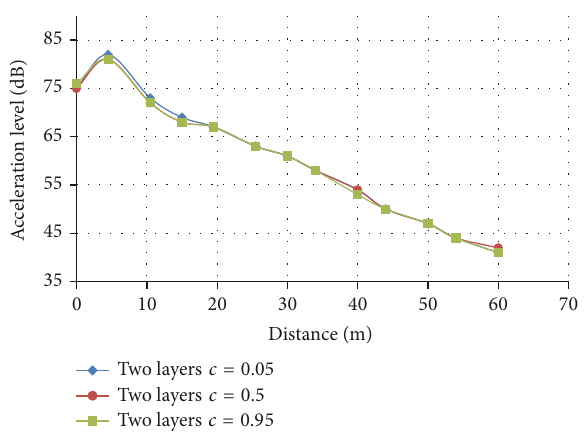
Figure 19: The comparison of acceleration level among conditions 1, 2, and 3 in Scheme 2 .